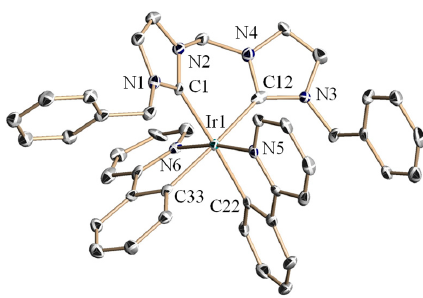
Figure 4. Molecule structure of 4c in the solid state. Hydrogen atoms, non-coordinating anions and disordered dichloromethane are omitted for clarity. Selected distances [Å] and angles [°]: Ir1-C1 2.113(8), Ir1-C12 2.086(10), Ir1-C22 2.055(8), Ir1-C33 2.066(9), Ir1-N5 2.055(8), Ir1-N6 2.056(7), C22-Ir1-